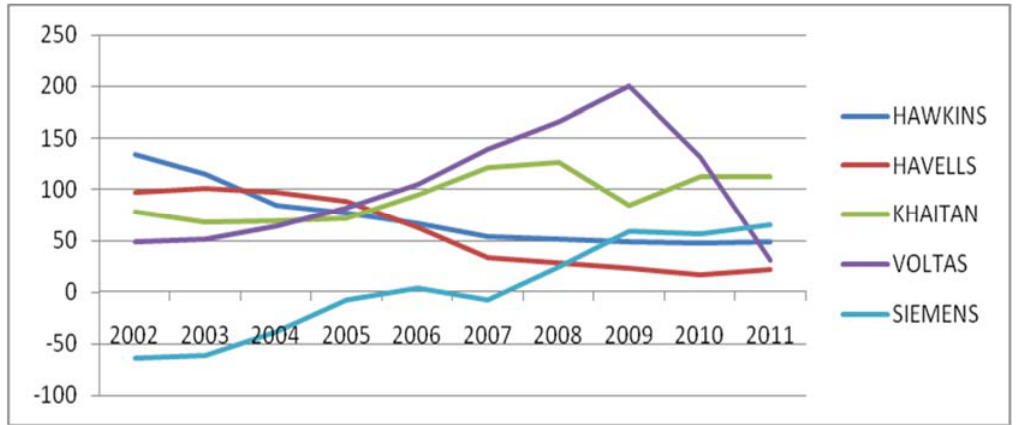
Fig. 1. Cash conversion cycle of consumer durable sector